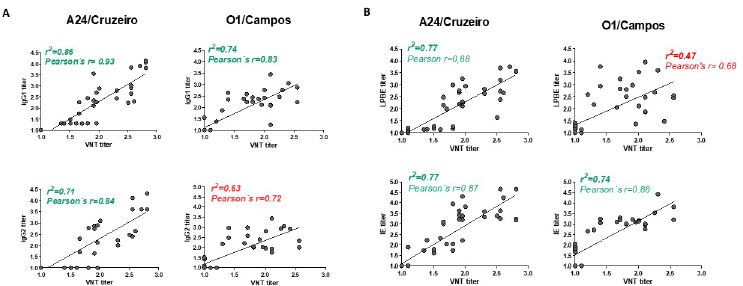
Fig 4. Correlation between virus neutralizing and ELISA titers. (A) Correlation between neutralizing antibody titers (VNT titer) and IgG1 (upper panel) or IgG1 (lower panel) for both A24/Cruzeiro and O1/Campos strains. (B) Correlation analysis between VNT titers and total antibody levels estimated by LPBE (upper panels) or IE (lower panels). Linear correlation coefficients (r2) and Pearson´s r values are shown in each graph. Red values indicate a poor correlation between VNT and IgG2 or LPBE titers for O1/Campos strain.